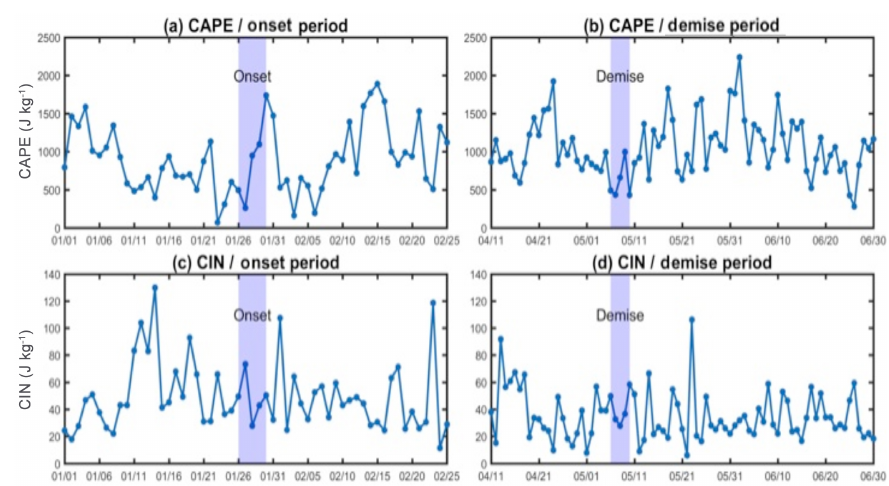
Figure 7. Daily variation of CAPE and CIN (Jkg − 1 ) from 1 January to 25 February 2015 (around the onset of the rainy season) and from 11 April to 30 June (around the demise of the rainy season) at Manaus. Pentads of the onset and demise are identified with blue vertical bars.